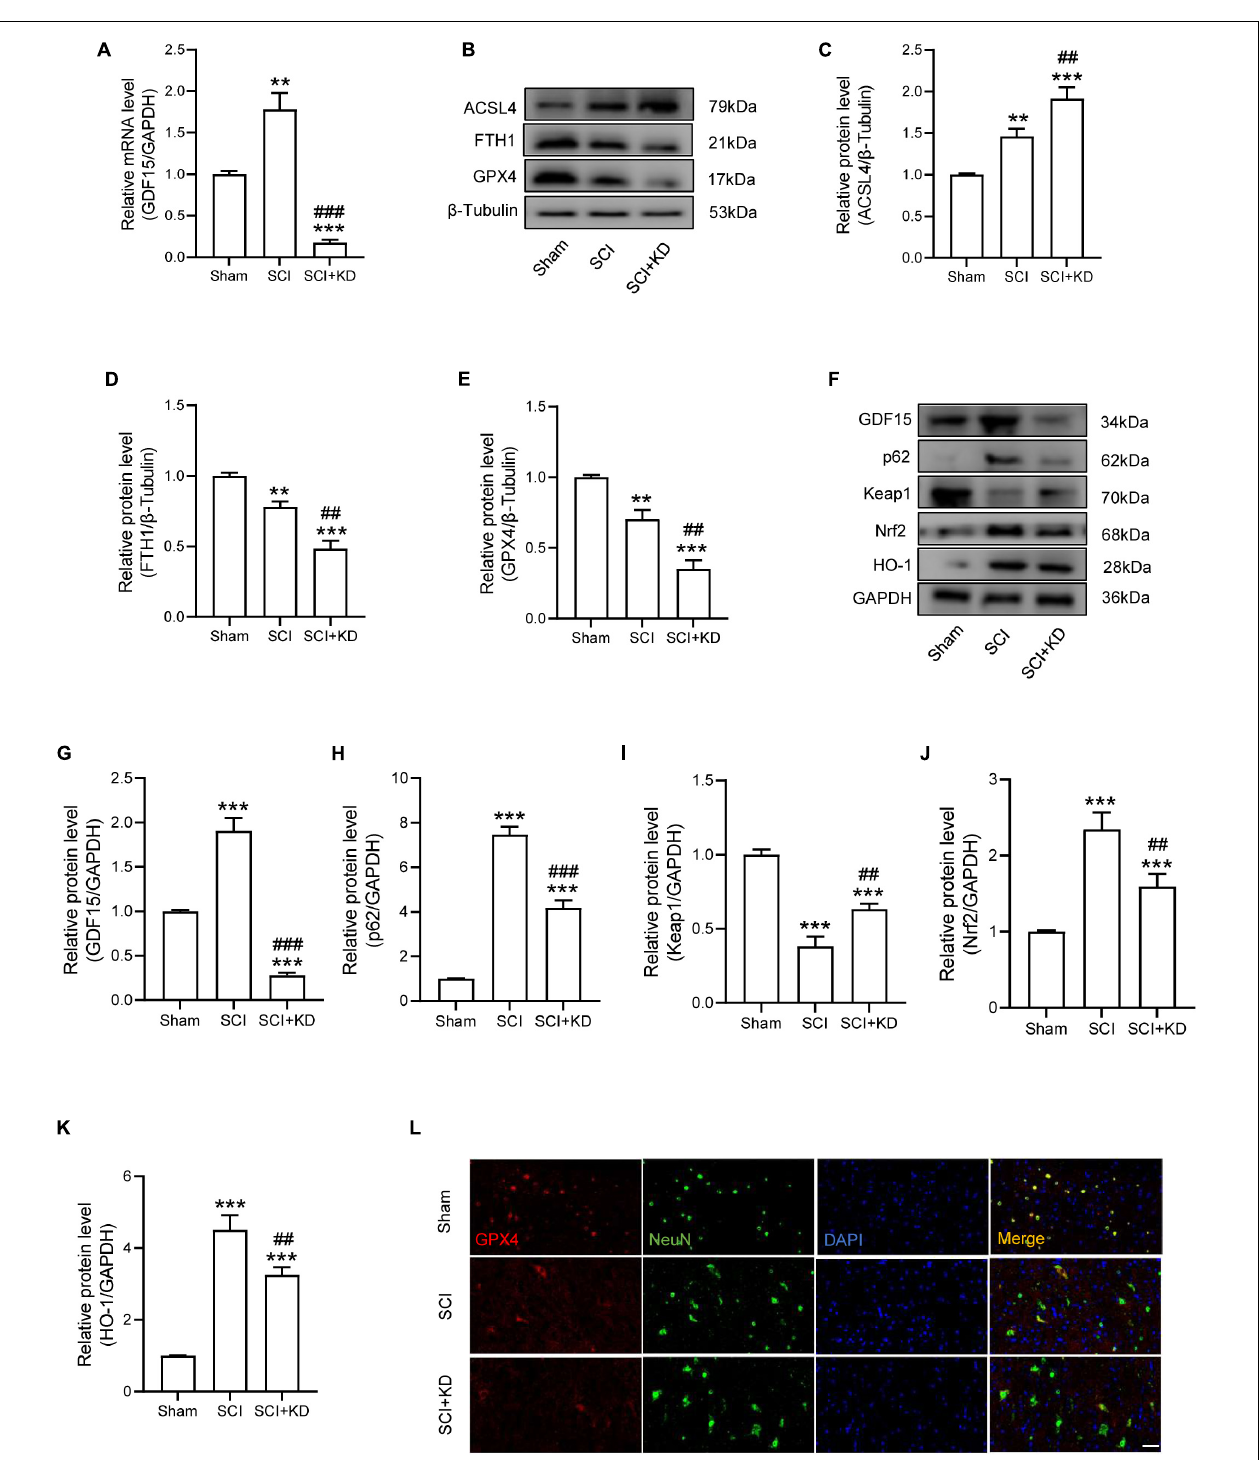
FIGURE 4 | Silencing GDF15 aggravated ferroptosis after SCI via destabilizing p62 and Nrf2 level. (A) Relative mRNA level of GDF15 in SCI mice after knockdown ( n = 6). (B) Western blotting of ACSL4, FTH1, and GPX4 protein levels at 1 dpi in Sham, SCI, and SCI + KD mice ( n = 3). (C–E) Bar graph showing a quantitative analysis of ACSL4, FTH1, and GPX4 ( n = 3). (F) Western blotting performed for GDF15, p62, Keap1, Nrf2, and HO-1 at 1 dpi in Sham, SCI, and SCI + KD mice ( n = 3). (G–K) Bar graph showing a quantitative analysis of GDF15, p62, Keap1, Nrf2, and HO-1 ( n = 3). (L) Double IF of GPX4-1 (red) and NeuN (green), obtained from longitudinal sections centered around central canal at 1 dpi in Sham, SCI, and SCI + KD mice (Scale bar = 40 µ m). The error bars represent the SD. ** p < 0.01, *** p < 0.001, vs. Sham group; ## p < 0.01, ### p < 0.001, vs. SCI group by one-way ANOVA followed by Tukey’s post hoc analysis.